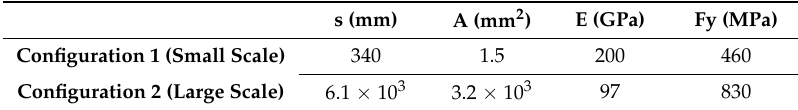
Table 1. Modified Catenary Configuration